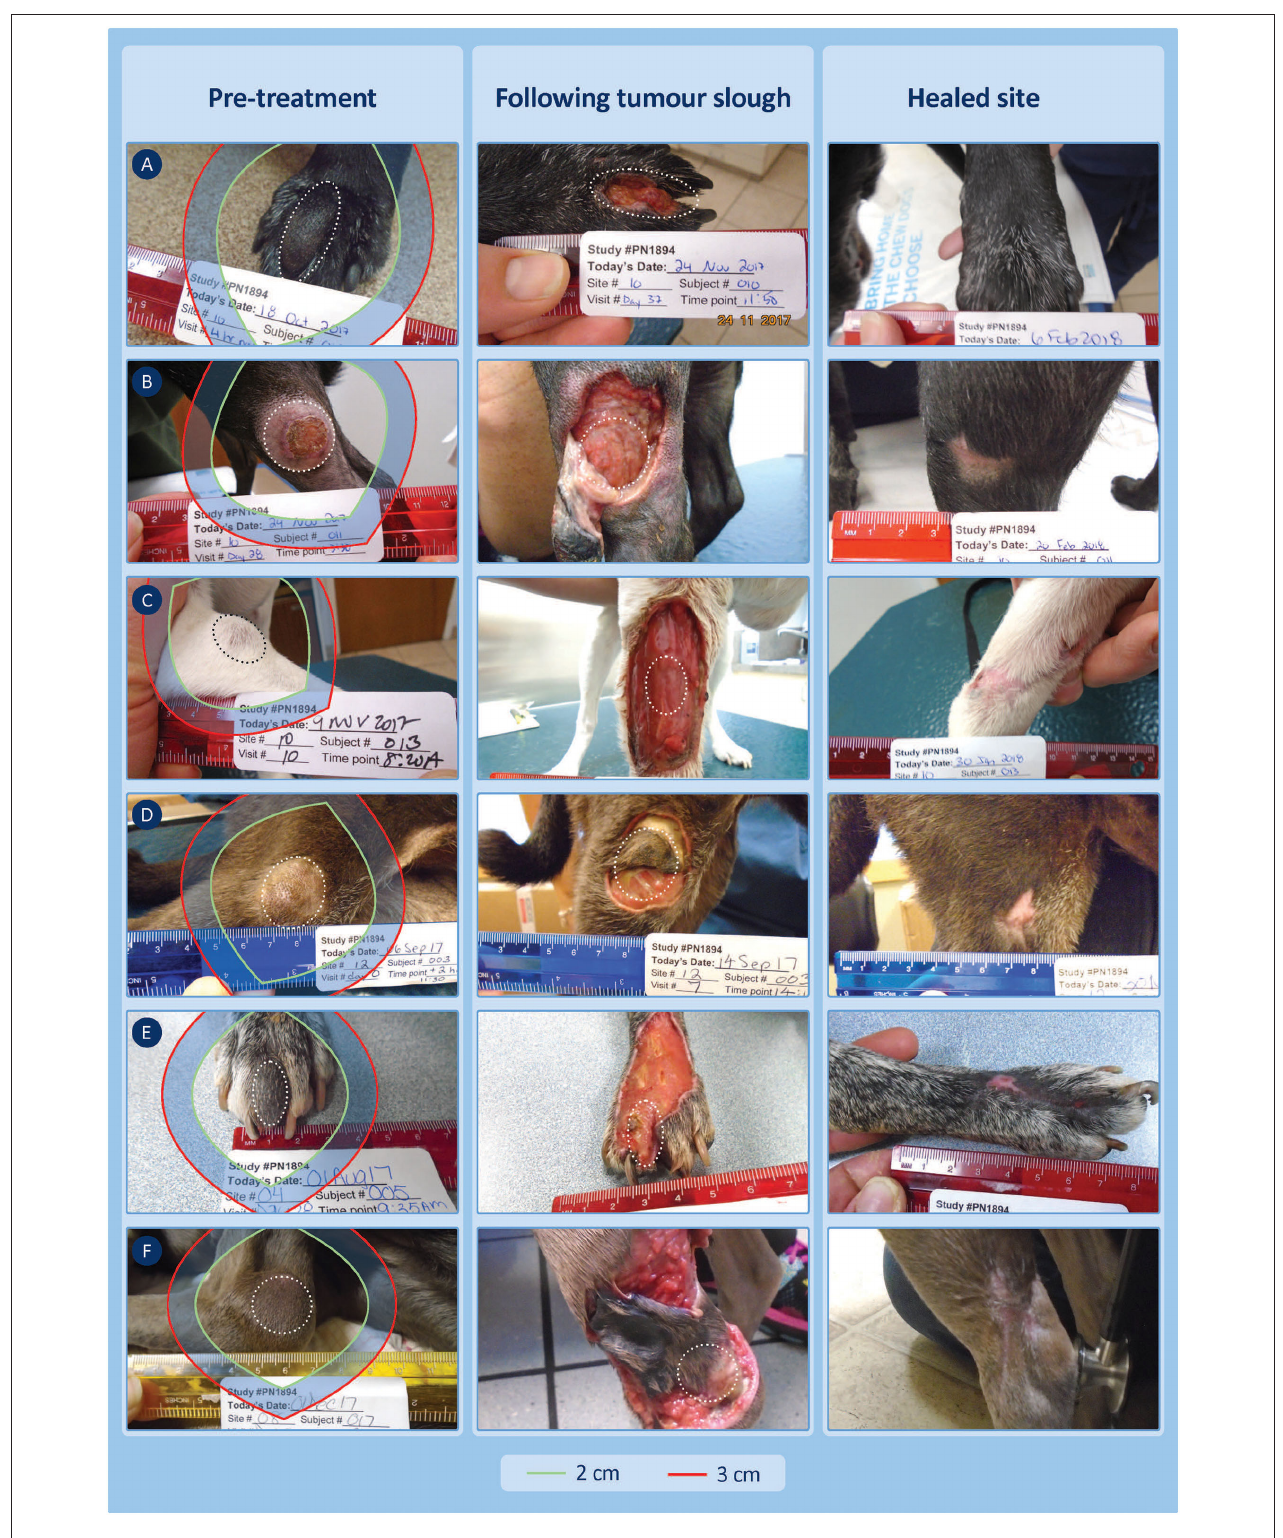
FIGURE 6 | Six examples of lower limb cases treated with TT and recurrence free at 12 months showing the TT-mediated tissue deficit that formed 7–14 days after treatment. Theoretical surgical margins of 2 and 3cm are overlaid to illustrate the potential extent of tissue loss expected at surgery (see Supplementary Table